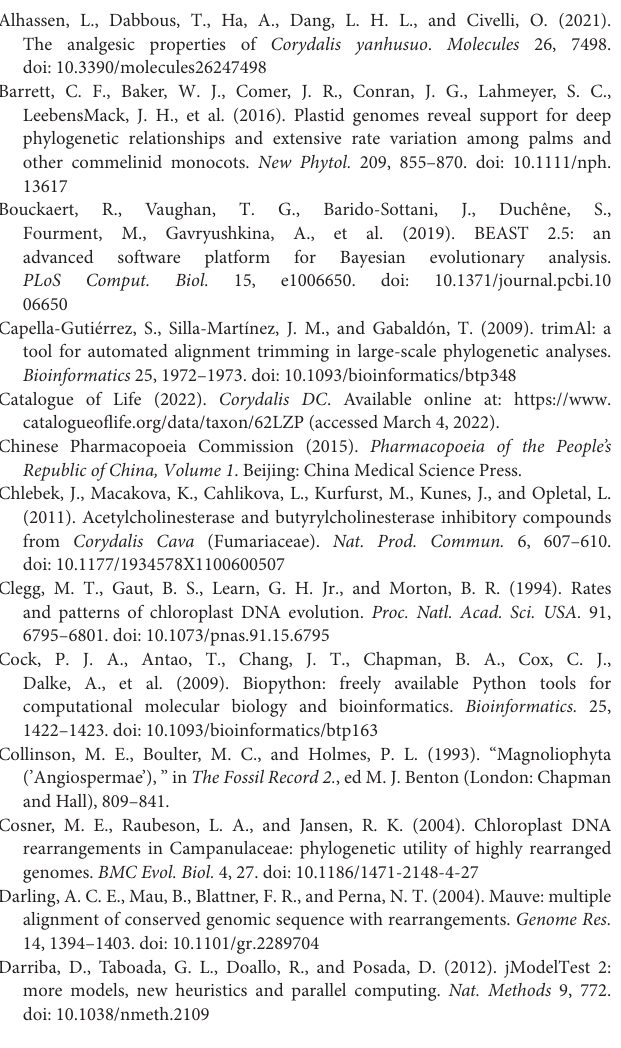
such as “-1,” “-2,” or “-3,” indicates the nucleotide that corresponds to the first, second, or third positions of the codon, respectively. Supplementary Table 4 | Ages of Corydalis clades estimated using BEAST. Age represents stem age (S) or the age of split from most recent common ancestors, unless otherwise indicated (crown age,